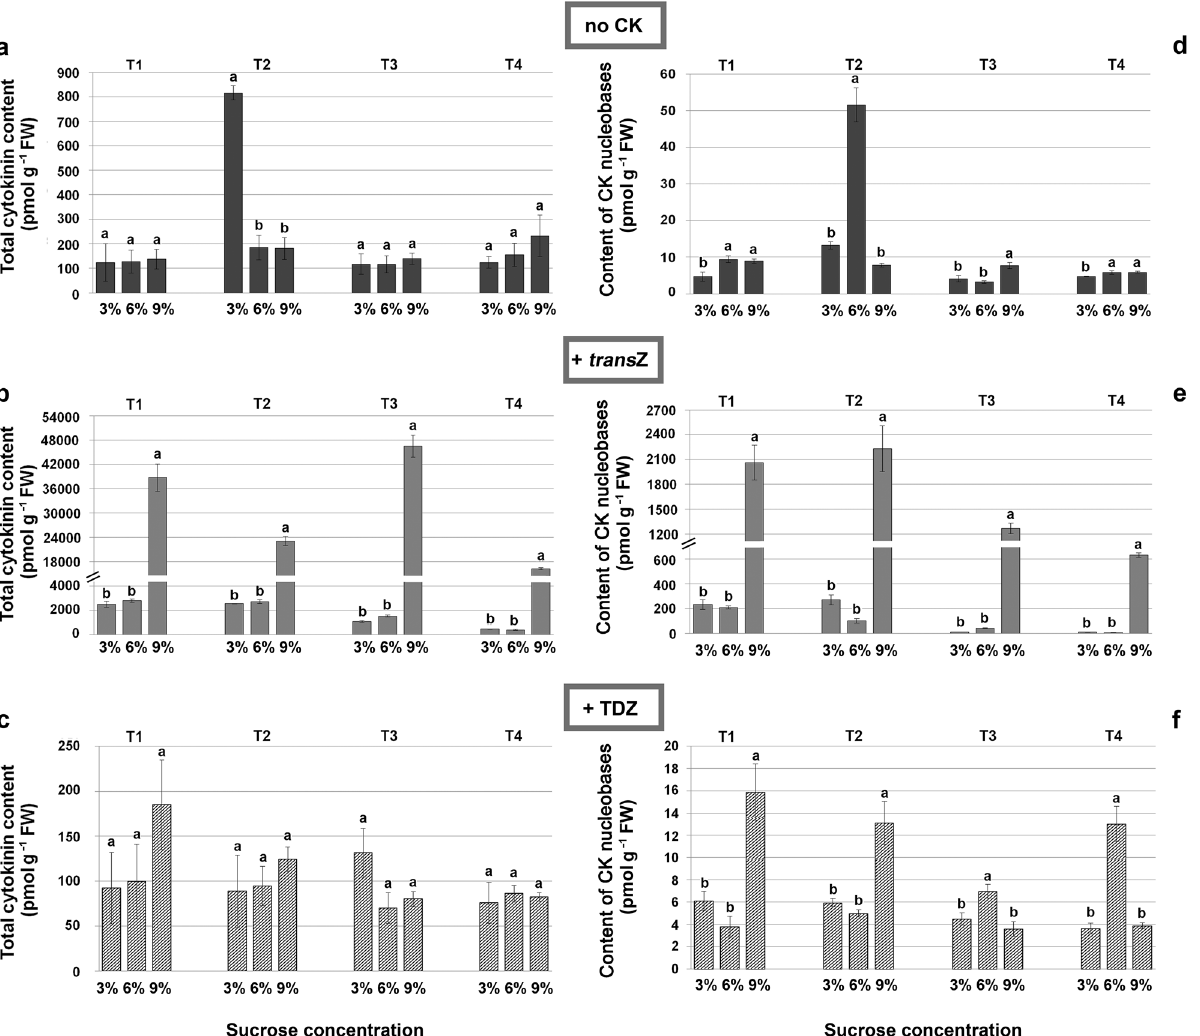
Figure 2. Contents (in pmol g −1 FW) of total cytokinins ( a – c ) and CK nucleobases ( d – f ) in four developmental stages (T1–T4) during kohlrabi (cv. Vienna Purple) growth and de novo shoot organogenesis on media containing 3/6/9% sucrose without the presence of cytokinins ( a , d ), with 2 mg L −1 trans Z ( b , e ) or with 2 mg L